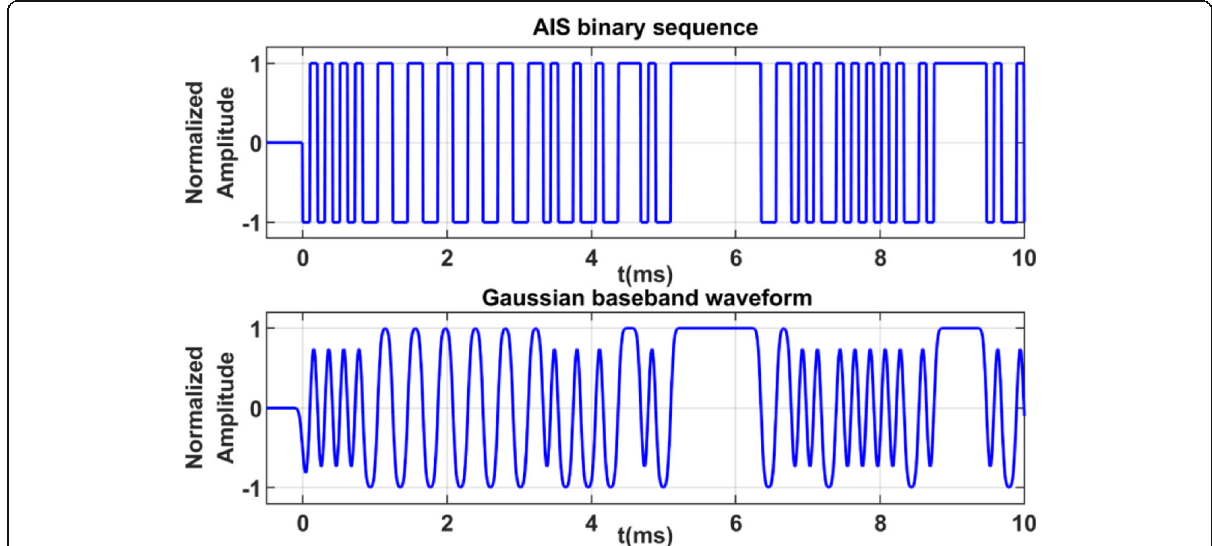
Fig. 2 AIS binary sequence and Gaussian baseband waveform: The upper subfigure is the AIS binary sequence and the bottom subfigure is the Gaussian baseband waveform. The x -axis denotes the time in milliseconds, and the y -axis is the normalized amplitude. The figure shows that the hopping edge in the binary sequence corresponds to the bit-0-phase in the Gaussian baseband waveform